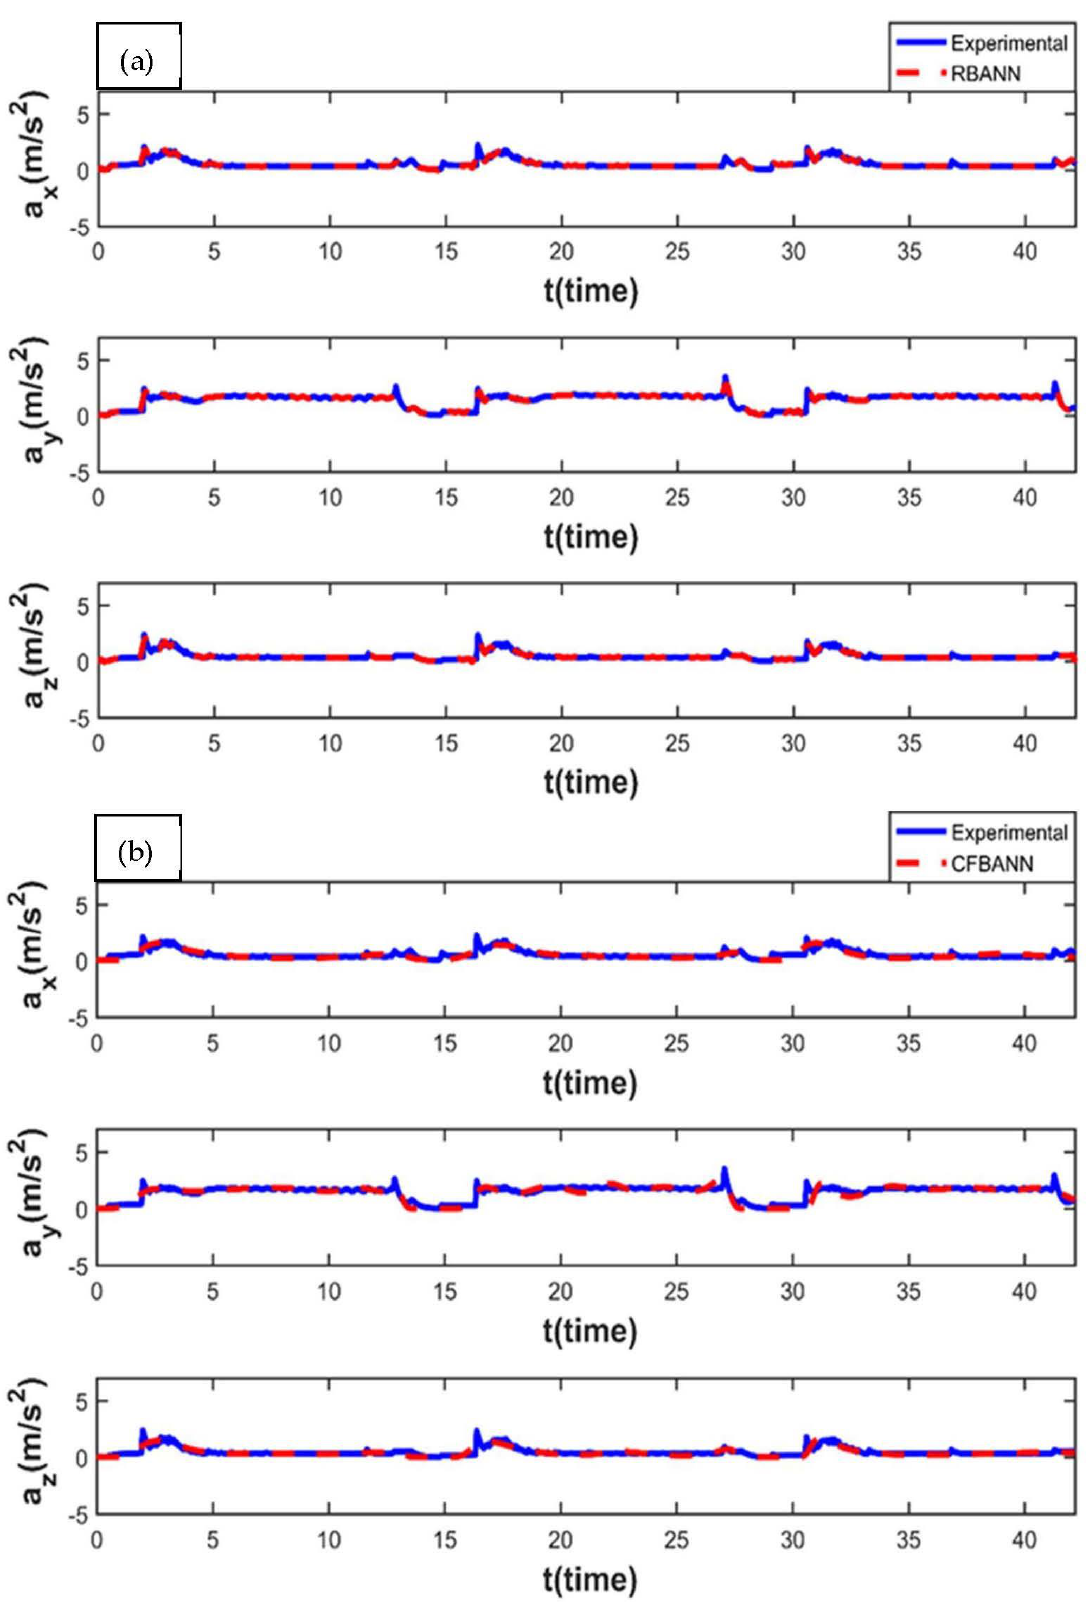
Figure 8. Experimental and ANN results obtained for the working condition of 11 s and 6.25 bar: ( a ) RBANN; ( b ) CFBANN.